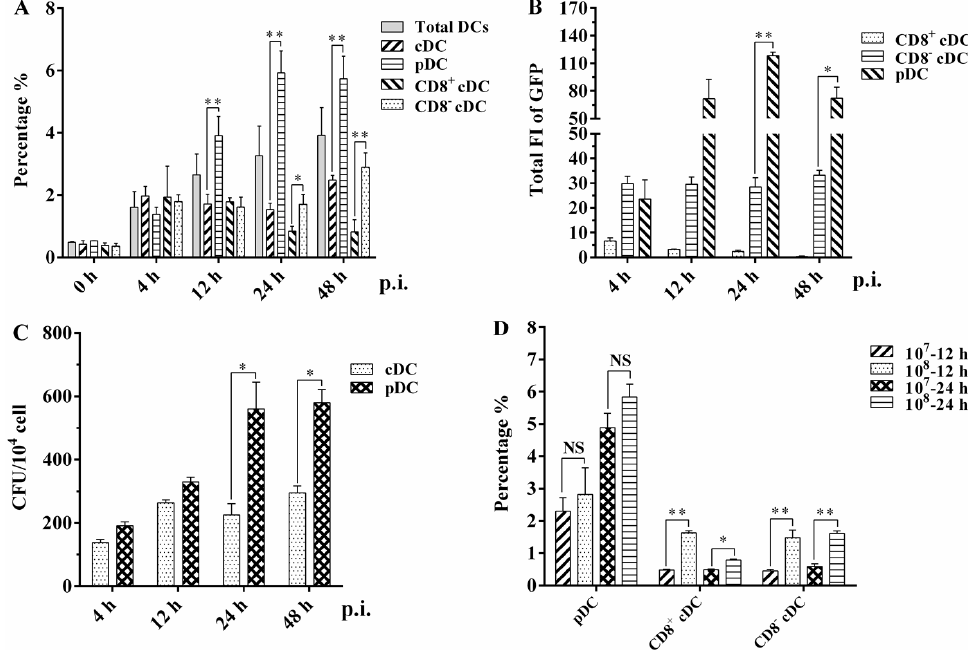
Figure 2. Infection analysis of different splenic DC subsets in mice injected with rBCG-GFP: ( A ) Infection rate of murine splenic total DC, cDC, pDC, CD8 + cDC, and CD8 - cDC was analyzed using FACS at different hours post-infection (p.i.). ( B ) Total GFP fluorescence intensity (FI) of murine splenic CD8 + cDC, CD8 - cDC, and pDC was calculated by the mean GFP FI multiplied the cell number of each DC subset among 10 4 splenic cells. ( C ) CFU counting of intracellular rBCG-GFP in splenic cDC and pDC subsets; ( D ) infection rate of splenic CD8 + cDC, CD8 - cDC, and pDC subsets when mice were immunized with different CFUs of rBCG-GFP. The experiment was repeated three times, and data are shown with the mean value of the three independent experiments. The bar graphs show the mean ± SD. * P < 0.05; ** P < 0.01; NS, no significance .